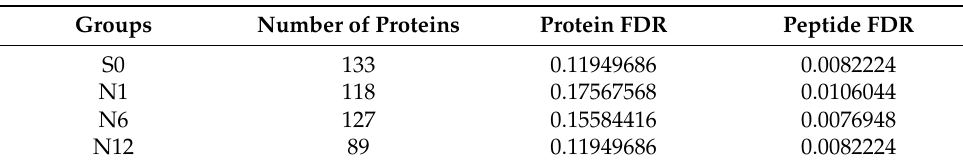
Table 1. The number of Bis-probe captured proteins as well as protein and peptides FDR identified after liquid chromatography-tandem mass spectrometry analysis ADSCs and ADSCs treated with BME in each respective timepoint.